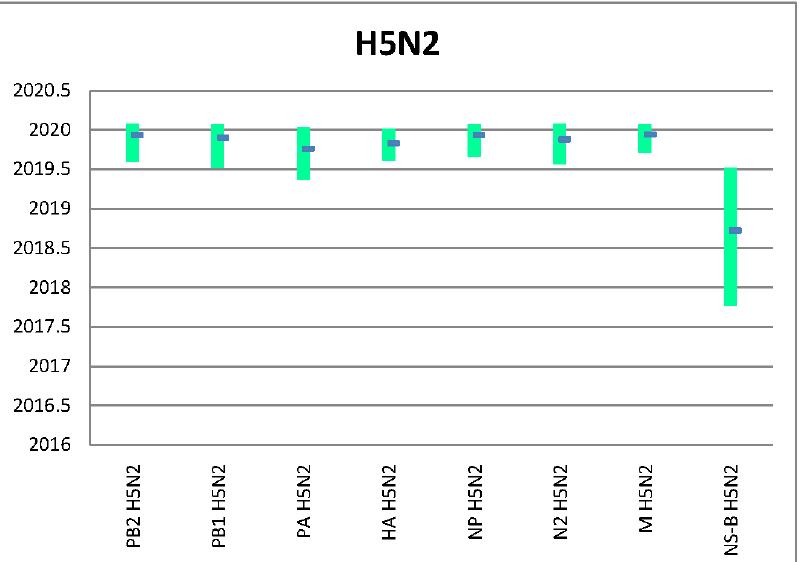
Figure 3. Time to the most common recent ancestor (tMRCA) calculated for each gene segment for the 2019–2020 Bulgarian H5N8 (grey box in Figures 1 and S1–S8) and the H5N2 (light green box in Figures 1 and S1–S8)